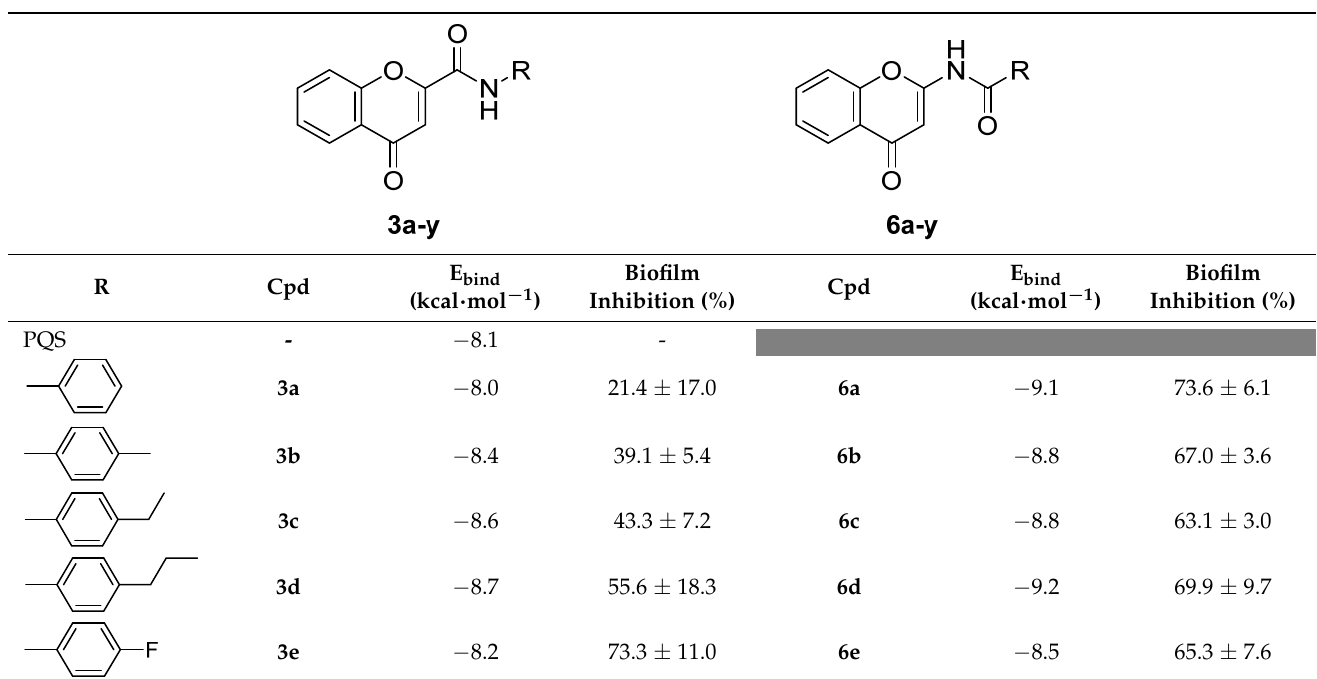
6 (traces) All yields correspond to isolated products. E.P.N.I = expected product was not isolated. Table 2. Docking scores (E bind , kcal · mol − 1 ) and in vitro anti-biofilm activity data for the pairs of direct ( 3a – y ) and retro ( 6a – y ) chromone carboxamides. The anti-biofilm activity is expressed in % of inhibition as the mean ± SD of 3 independent experiments (n = 3 ∗ 2). NA: non-active (% inhibition < 10.0%).